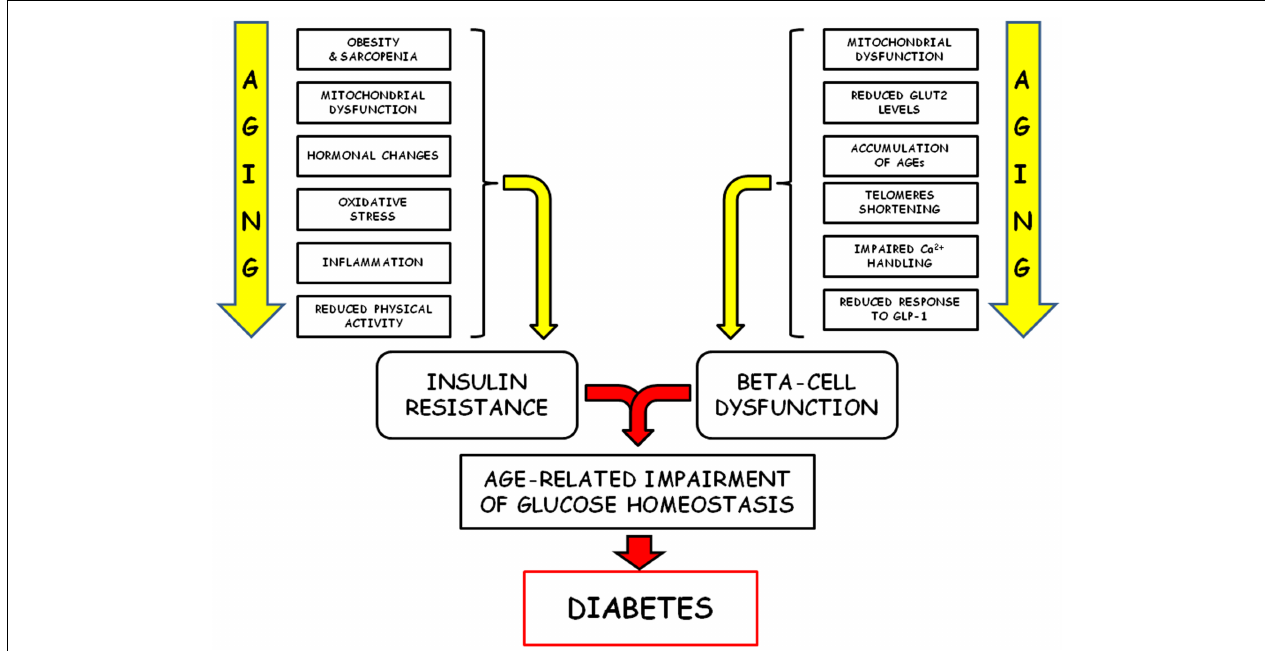
FIGURE 2 | Schematic representation of the pathophysiological factors responsible of the age-related failure of glucose homeostasis is shown .